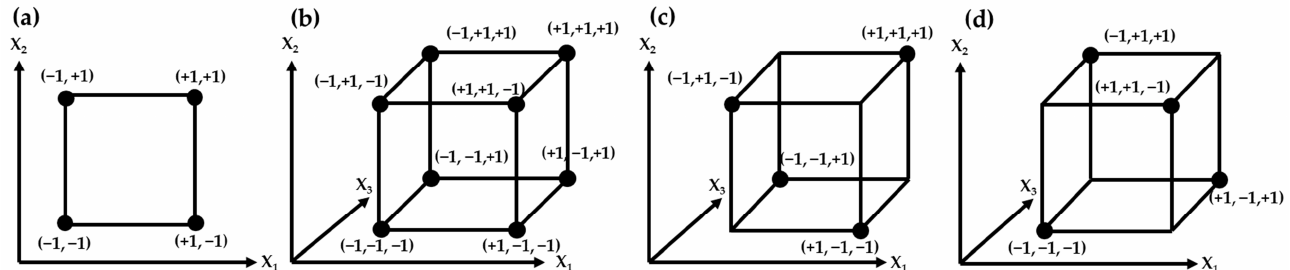
Figure 3. Illustration of two-level FFD matrix for 2-factors (2 2 ), ( a ) 3-factors (2 3 ), ( b ) 2-level fFD matrix with 3-factors, and ( c ) and its complementary design matrix ( d ).